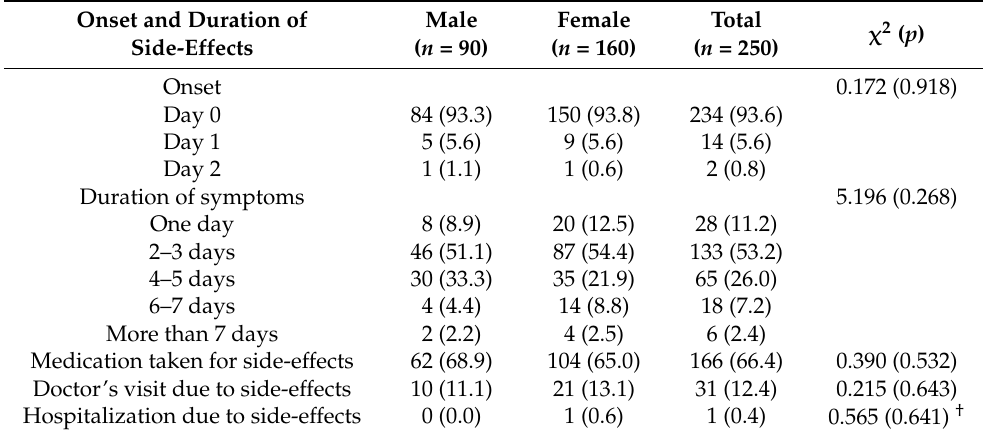
Table 7. The onset, duration, and management of COVID-19 vaccine side-effects reported among the healthcare workers participated in the study ( n =